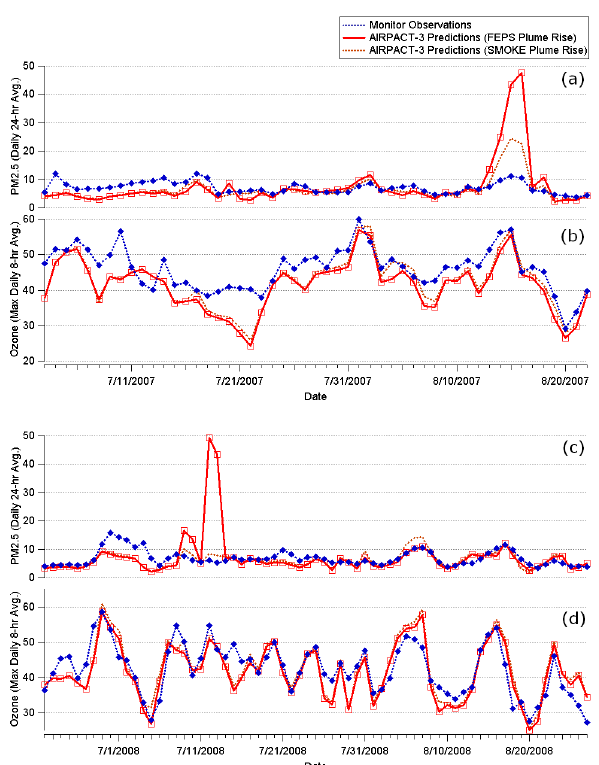
Figure 8. 3 July to 22 August 2007 (top) daily 24h average PM 2 . 5 averaged across 67 sites (a) and max daily 8h average ozone aver- aged across 10 sites (b) ; 22 June to 27 August 2008 (bottom) daily 24h average PM 2 . 5 averaged across 82 sites (c) and max daily 8h average ozone averaged across 18 sites (d) from. Model simulations are shown in red with squares (FEPS plume rise) and orange dotted (SMOKE plume rise) while observations are shown in dotted blue with